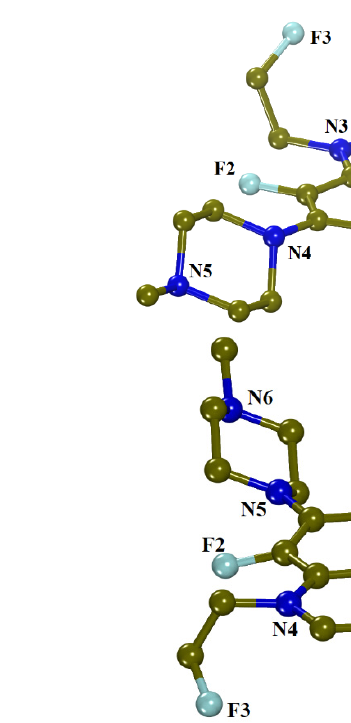
Figure 2. A drawing of the molecular structure of 3 with only the heteroatom labeling. Aromatic and methanol hydrogen atoms are omitted for clarity. Table 1. Selected bond distances and angles for complex 3 .